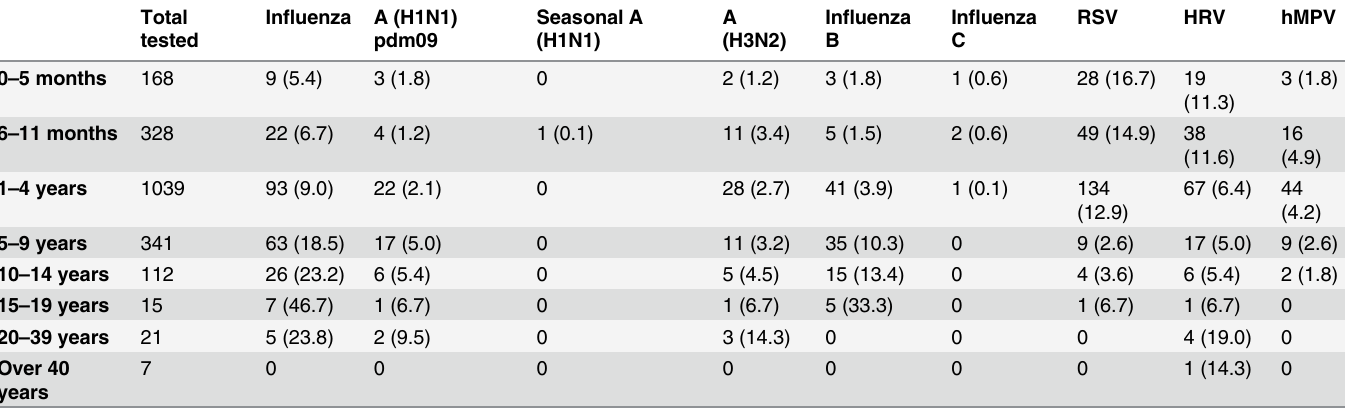
Table 3. Aggregate number of virus positives and positivity rates (%) by age group from 2010 to